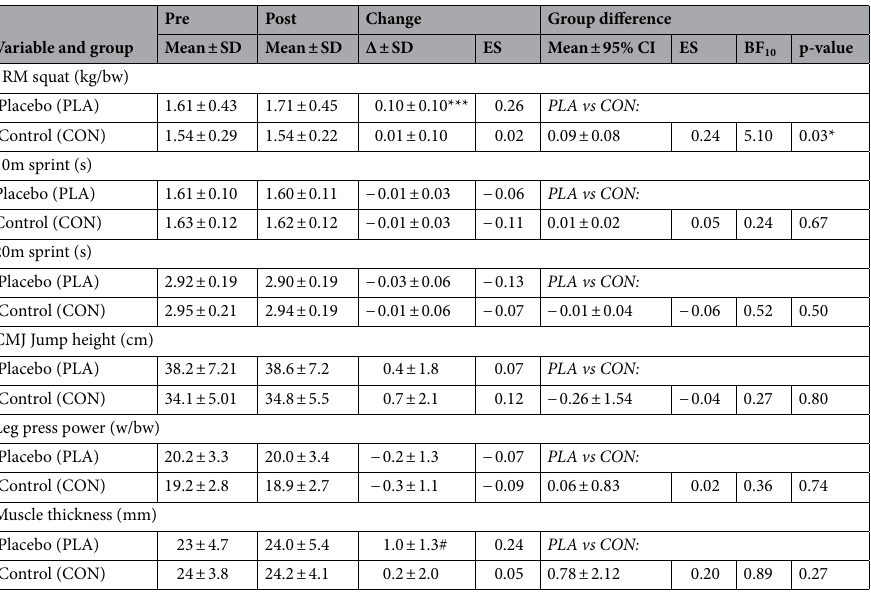
Table 2. Results from the main groups, individualized (Placebo [PLA]) vs control group (Control [CON]). 1RM 1-repetition maximum, CMJ countermovement jump, kg kilogram, s seconds, cm centimeters, W